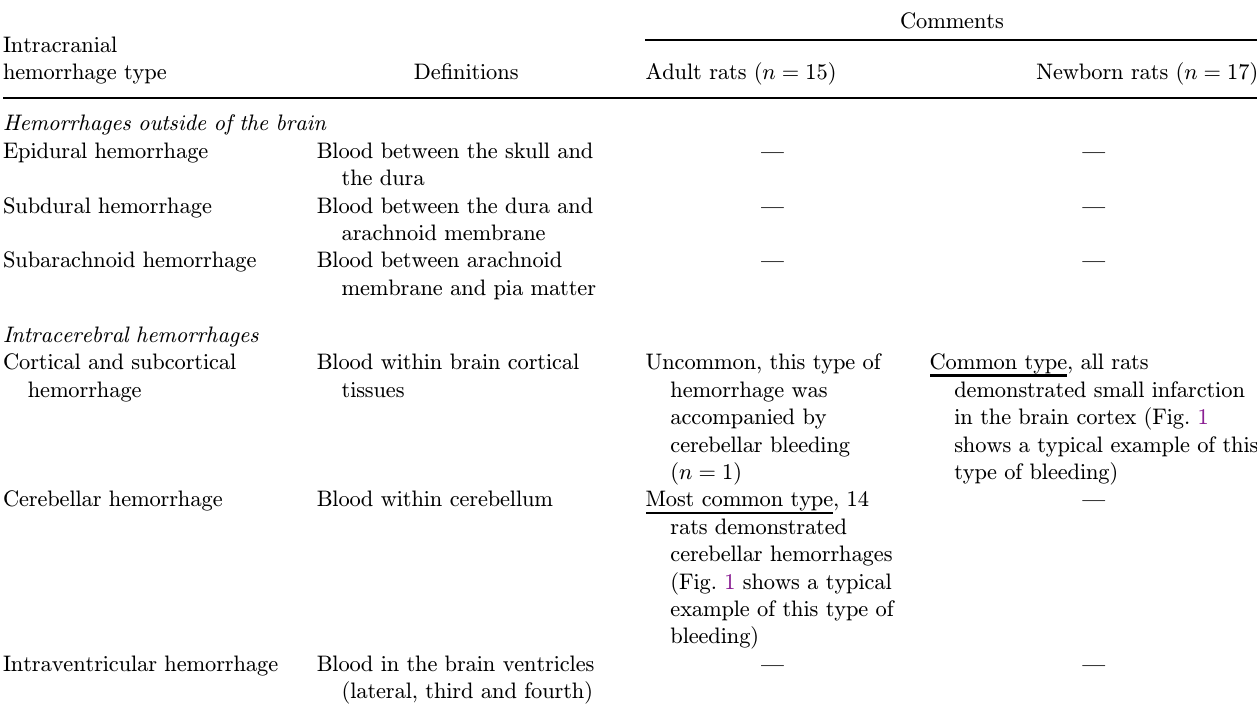
Table 1. The frequency of stress-induced hemorrhages in the di®erent anatomical structures of the brain in adult and full term newborn